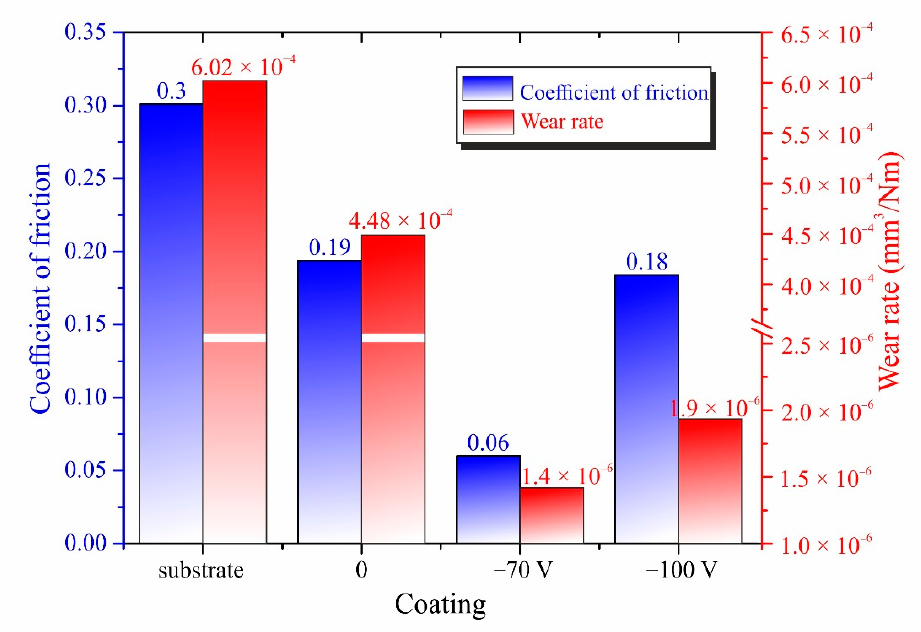
Figure 5. Averaged CoF and WR for VT6 substrate and TiCN coatings obtained at U s = 0, − 70, and − 100 V.